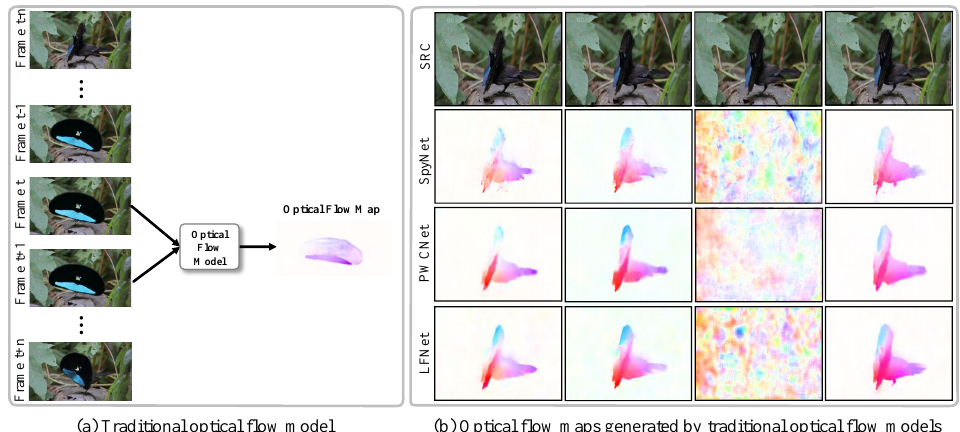
Figure 1. ( a ) It represents traditional optical flow models that only use two frames of images for optical flow calculation. ( b ) Optical flow maps generated by the traditional optical flow